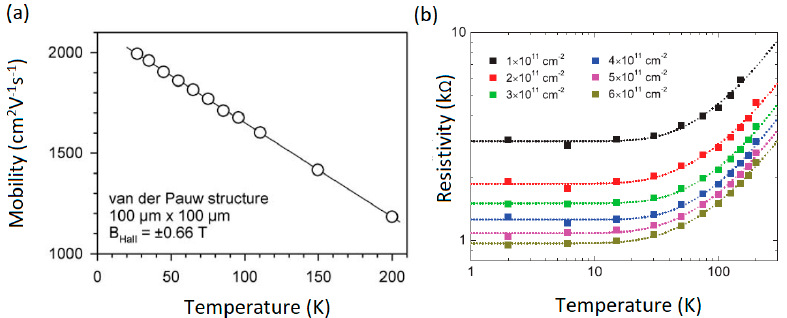
Figure 14. ( a ) Temperature dependent mobility of MLG on SiC (0001). Reprinted with permission from Reference [26]. Copyright (2009) Springer Nature. ( b ) Temperature dependent resistivity of MLG on SiC (0001). Reprinted with permission from Reference [123].